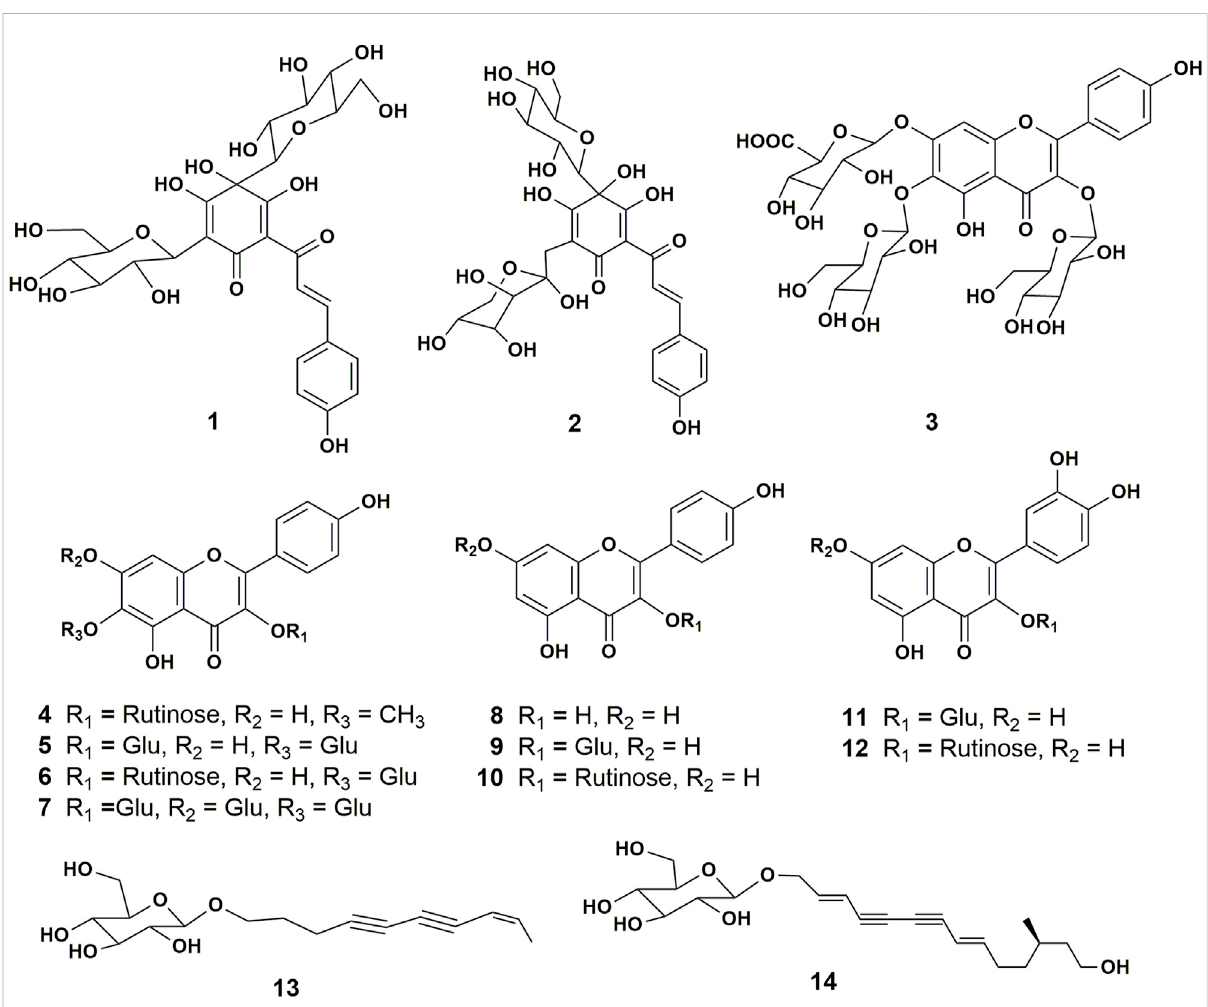
FIGURE 1 Structures of the chemical constituents isolated and identi fi ed from the fl orets of C. tinctorius . 1 , hydroxysaf fl or yellow A; 2, hydroxysaf fl or yellow C; 3, 6-hydroxykaempferol 3,6-d i-O -glucoside-7- O -glucuronide (HGG); 4 , 5,7,4 ’ -trihydroxy-6-methoxy fl avone-3- O -rutinoside; 5 , 6- hydroxykaempferol 3,6- di- β -glucoside; 6 , 6-hydroxykaempferol 3- O- β -rutinoside-6- O- β -glucoside; 7 , 6-hydroxykaempferol 3,6,7-tri- O- β - glucoside; 8 , kaempferol; 9 , kaempferol 3- O- β -glucoside; 10 , kaempferol 3-rutinoside; 11 , quercetin 3- O- β -glucopyranoside; 12 , Rutin; 13 , bidenoside C; 14 , (2E,8E)-tetradecadiene-4,6-diyne-1,12,14-triol-1- O- β